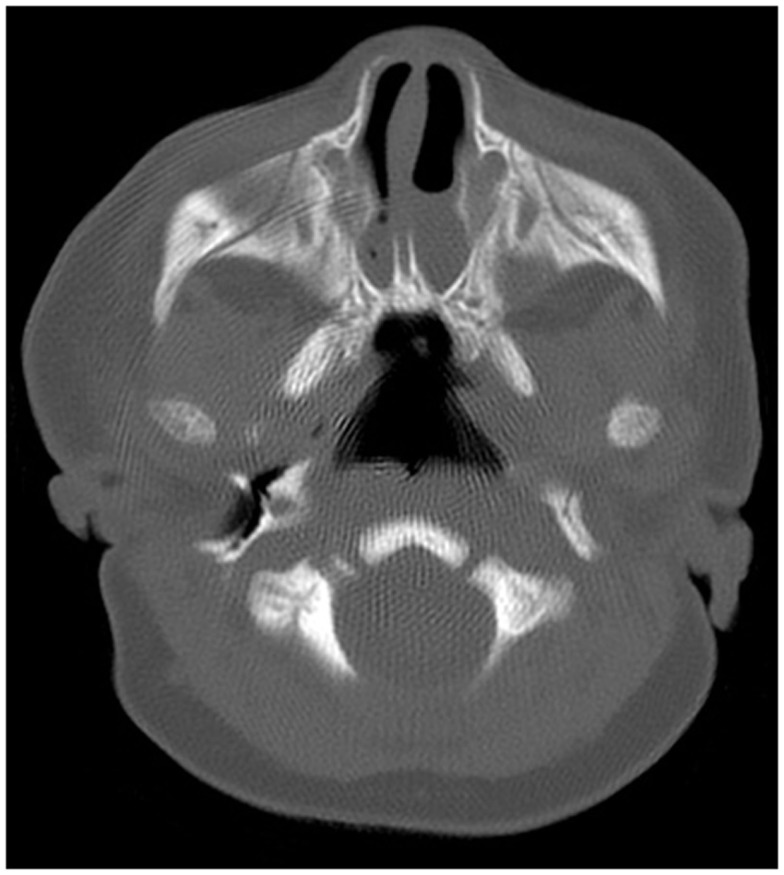
Axial CT scan of the nasal cavity in bone window at the level of choana.